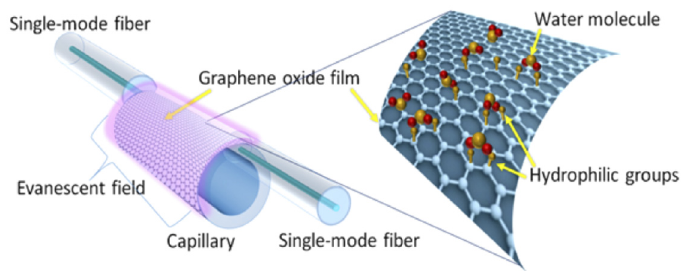
Figure 31. Point sensor. Humidity sensing based on GO and evanescent tunneling. Adapted with permission from [166] © OSA .